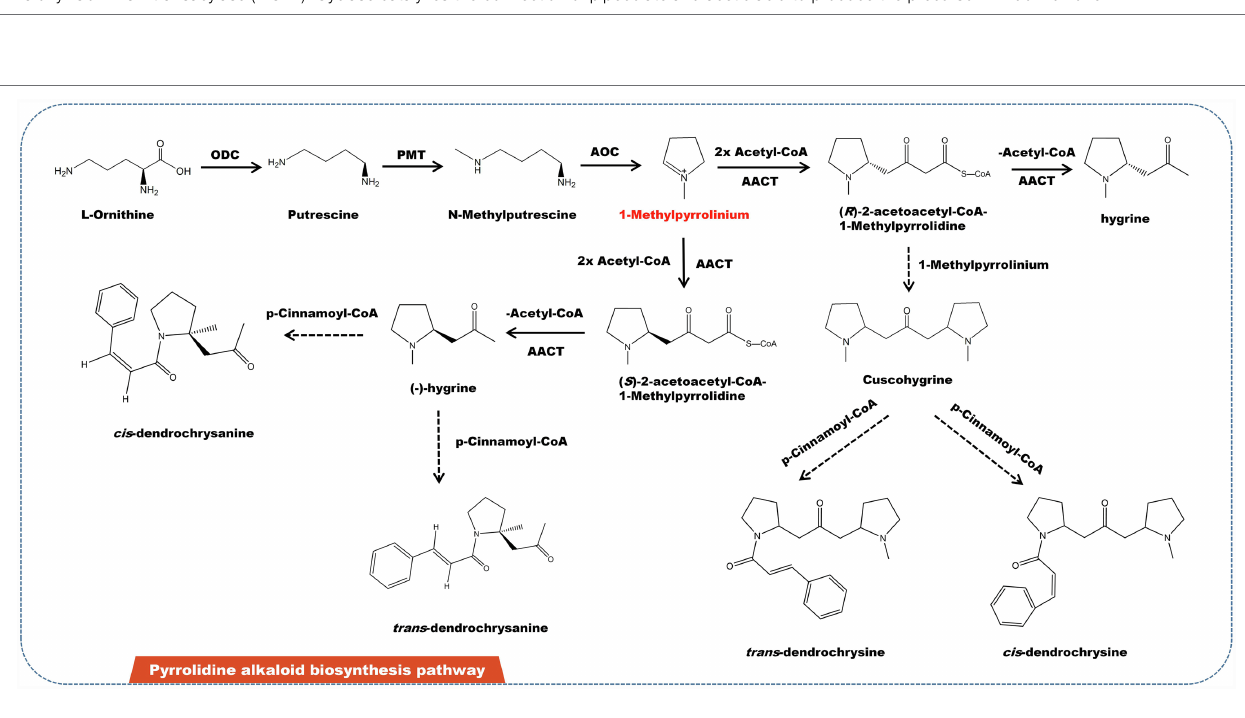
FIGURE 3 | A plausible biosynthesis pathway of indolizidine alkaloids. The dashed box represents the putative enzymes. The dashed arrow represents the speculated pathway. The multiple arrows represent multi-step reactions. Saccharopine dehydrogenase (SD), L-pipecolate oxidase (PO), phenyltransferase (PT), malonyl-CoA-ACP transacylase (MCAT). Cyclase catalyzes the connection of pipecolate and acetic acid to produce the precursor 1-indolizidinone.